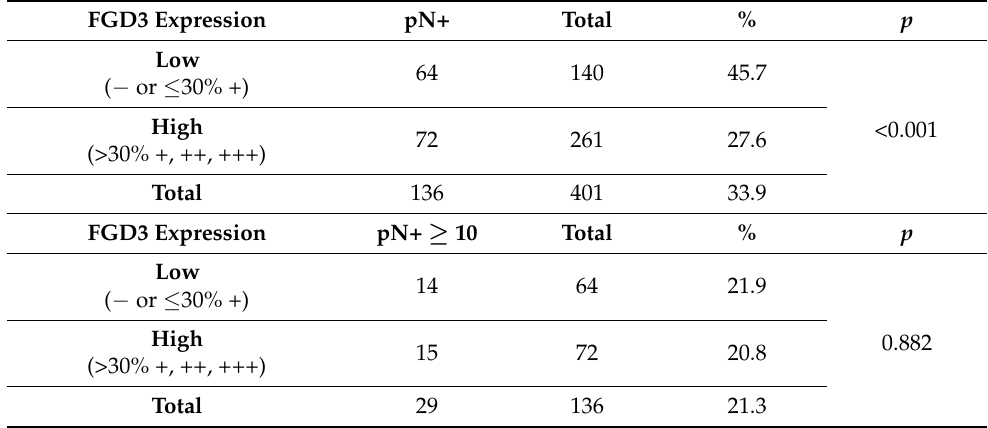
Table 3. Association between FGD3 expression and lymph node